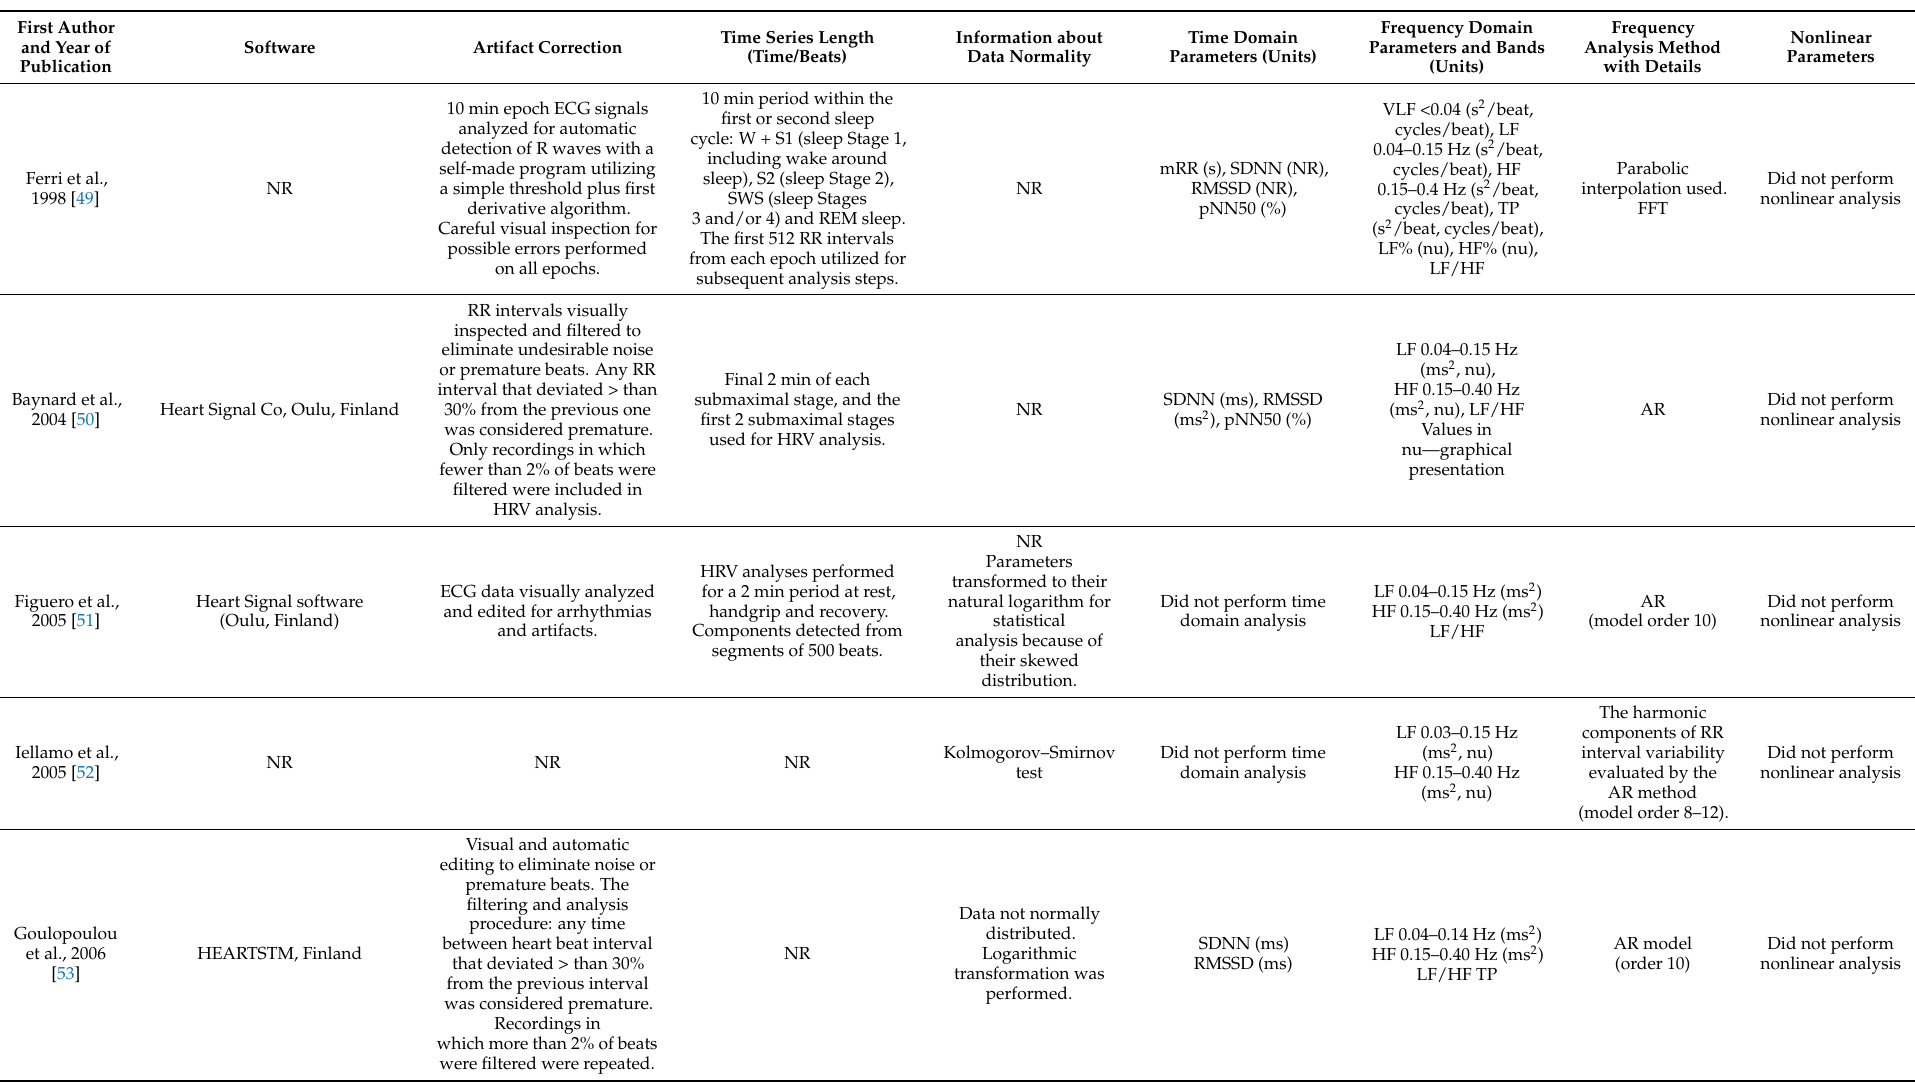
Table 2. Heart rate variability (HRV)